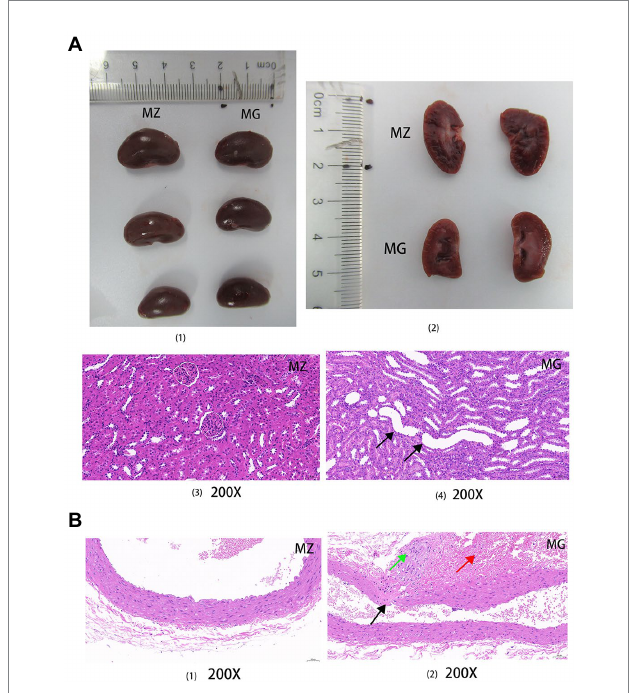
FIGURE 3 High salt diet caused kidney and blood vessel damage in rats. (A) Complete and sectional views of the kidneys in the MZ and MG groups (1, 2); HE staining sections of kidney in the MZ and MG groups (3, 4). (B) HE staining sections of vascular in the MZ and MG groups. MZ, normal group, MG, hypertensive group. Solid arrows of different colors indicated damage to the